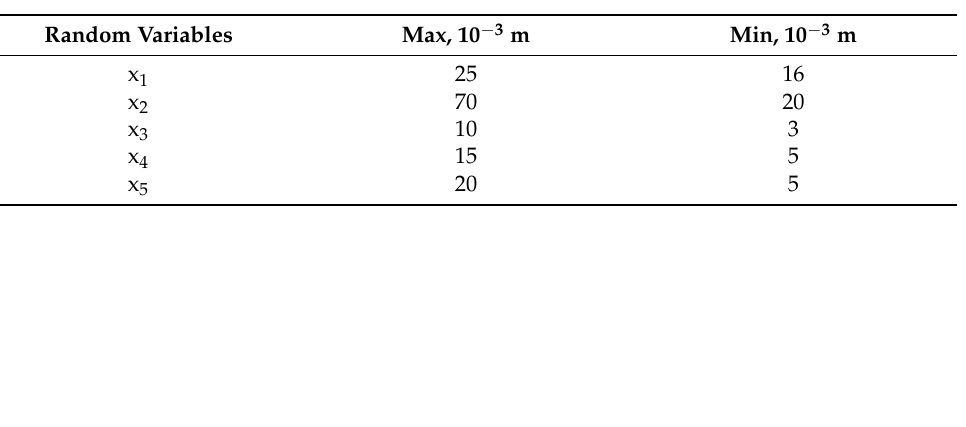
Figure 8. Cloud diagram of the first-order modal frequency of the reflector. Table 1. The range of variation of the dimensional parameters of the